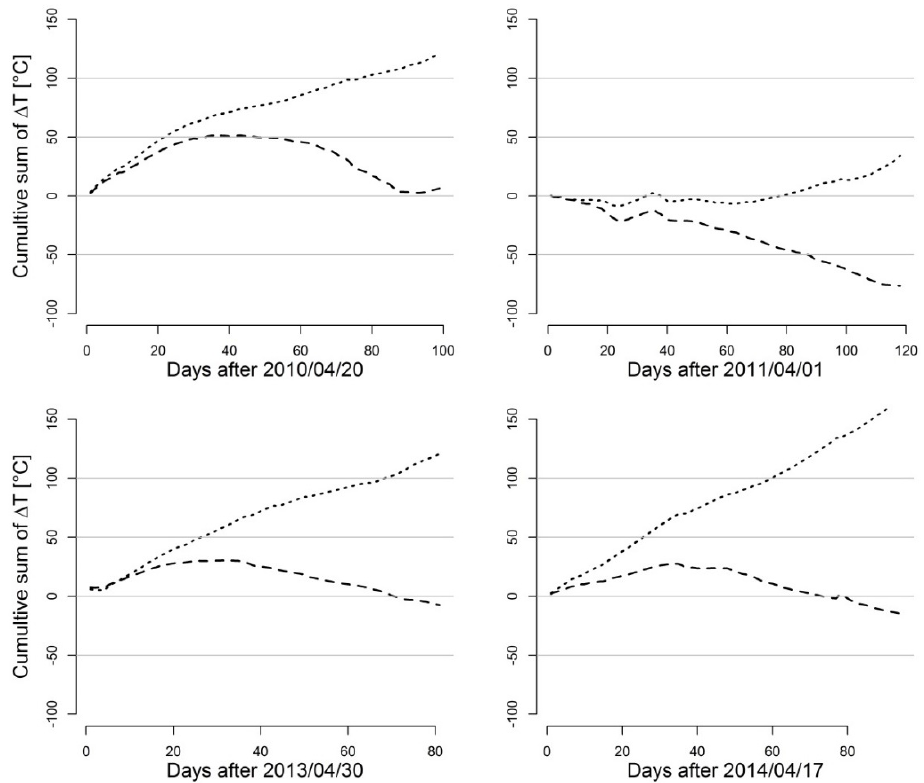
Figure 7. Cumulative sums of canopy to air temperature differences ( ∆ T (°C)) for the drought treatment plot (dotted line) and the irrigated plot (dashed line) using mean daily modeled surface temperatures ( ∆ T = T c,mean –T air,mean ) in 2010 ( top left ), 2011 ( top right ), 2013 ( bottom left ), 2014 ( bottom right ) (Hohenschulen research site).